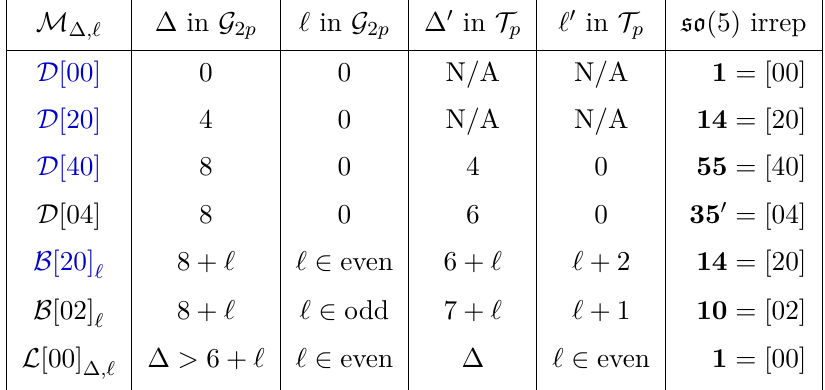
Table 1 . Scaling dimensions and spins of multiplets in S 2 × S 2 in the full correlator G 2 p , denoted as (∆ , ‘ ) , versus the reduced correlator T p , denoted as (∆ 0 , ‘ 0 ) . The operators in the 2d chiral algebra sector are denoted in